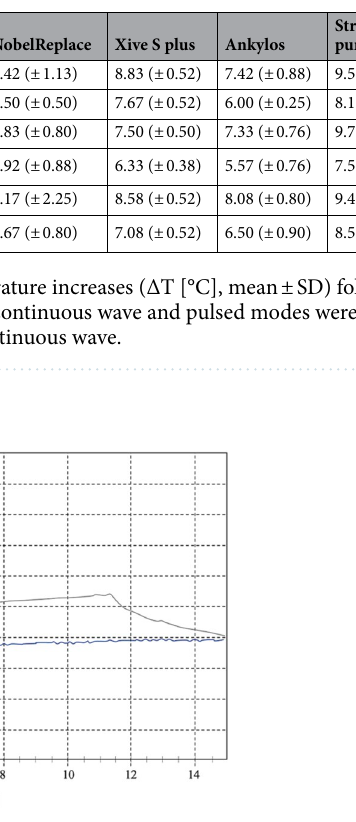
Figure 1. Temperature response curve for the NobelReplace Tapered Groovy RP 4.3 × 10 mm implant when subjected to 445 nm laser irradiation at 2 W for 10 s in continuous wave and non-contact mode. The blue line indicates the temperature at the apical recording